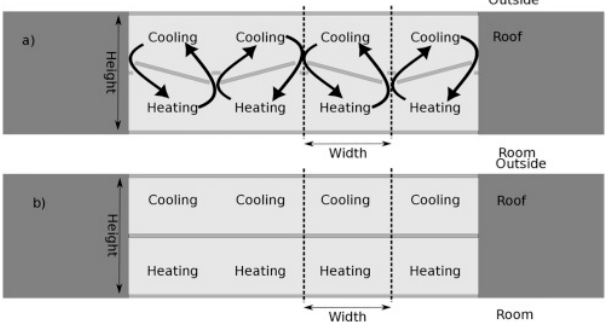
Figure 31. Triple glazing skylight ( a ) in cooling mode ( b ) and in insulating mode [160].